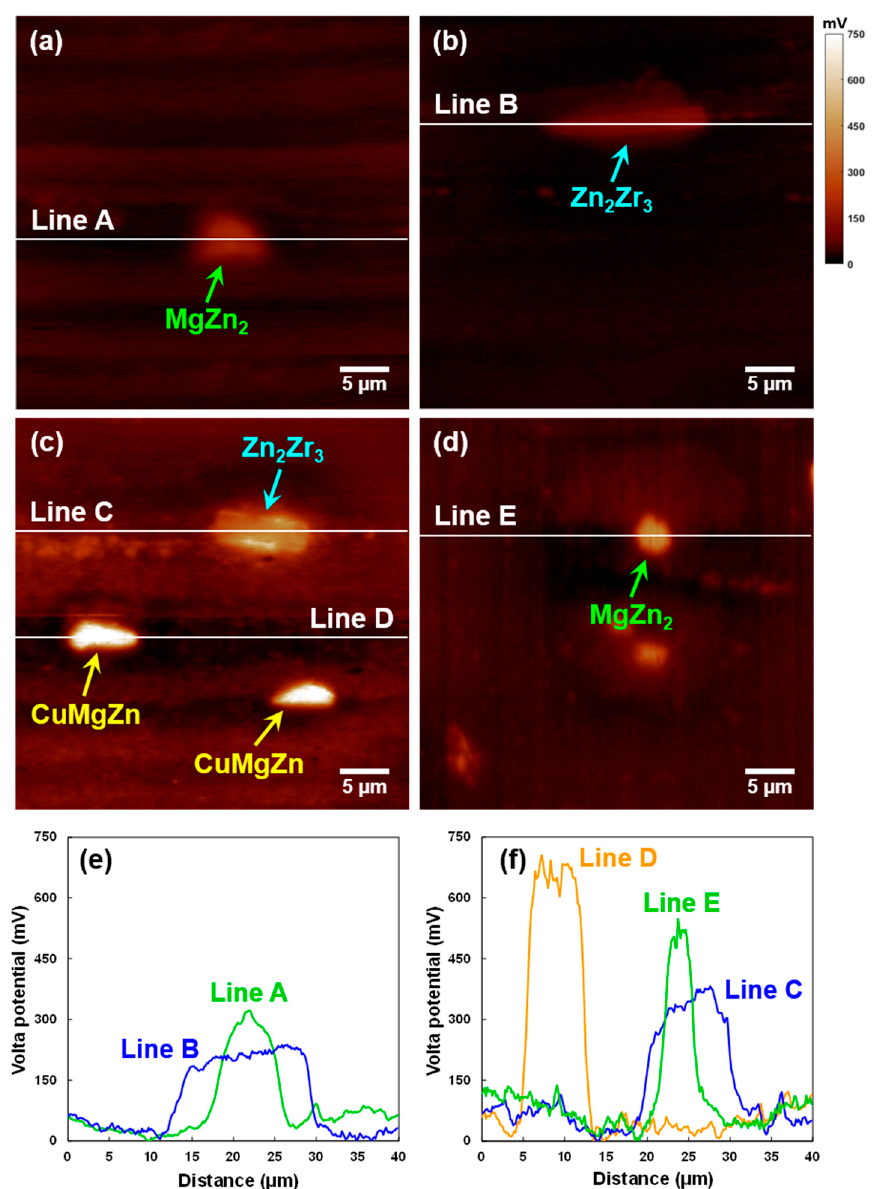
Figure 4. Scanning Kelvin probe force microscopy (SKPFM) images of the extruded ( a , b ) ZK60 and ( c , d ) ZKC601 alloys; and corresponding Volta potential profiles along the lines ( e ) A–B and lines ( f ) C–E in the SKPFM images.